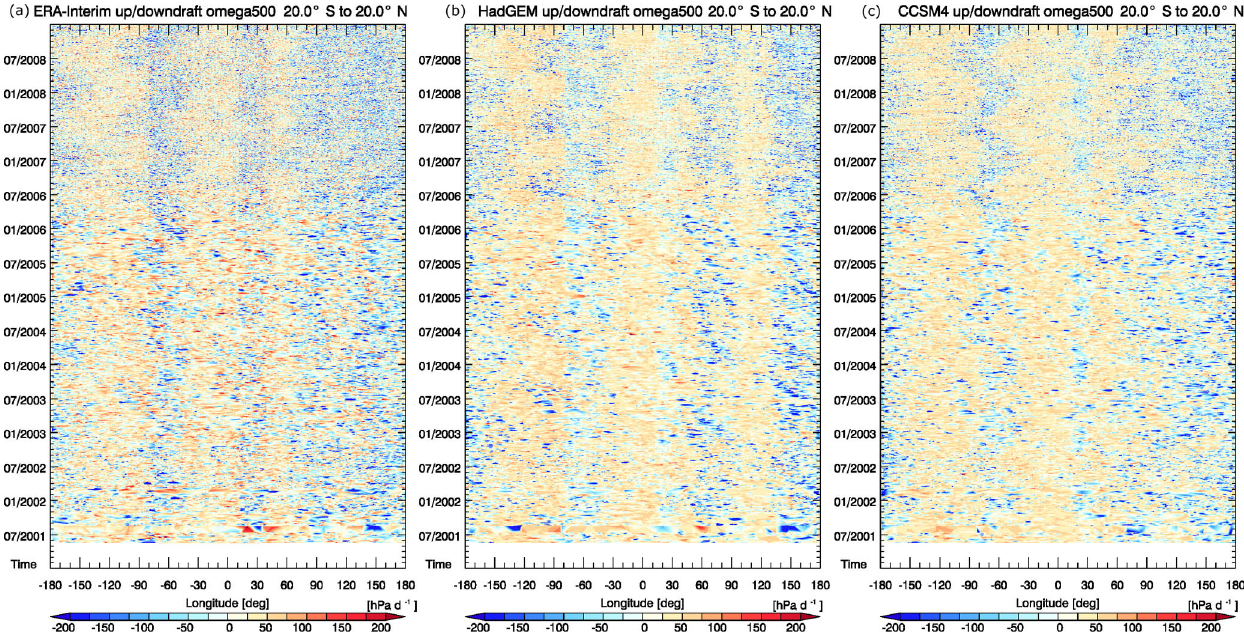
Figure 1. Tropical convection regions represented as function of time versus longitude in ERA-Interim as proxy for the observations (a) , the HadGEM2-A model (b) , and the CCSM4 model (c) , shown for co-locations with RO observations getting denser in 2006. Updraft (blue) denotes convection regions and downdraft (red) denotes non-convection